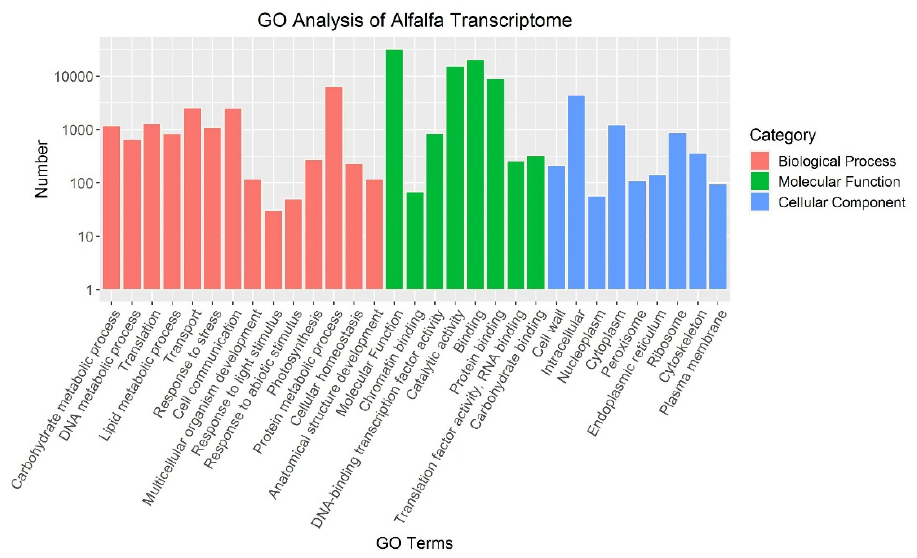
Figure 3. GO annotation of unique alfalfa transcripts. Note: GO terms are listed on the X -axis, and the numbers of transcripts grouped in the GO terms are indicated on the Y -axis. Red bars represent biological processes; the green bars represent molecular functions; and the blue bars represent cel- lular components.